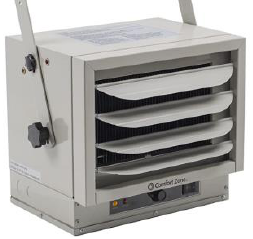
Figure 7. Industrial air heater.